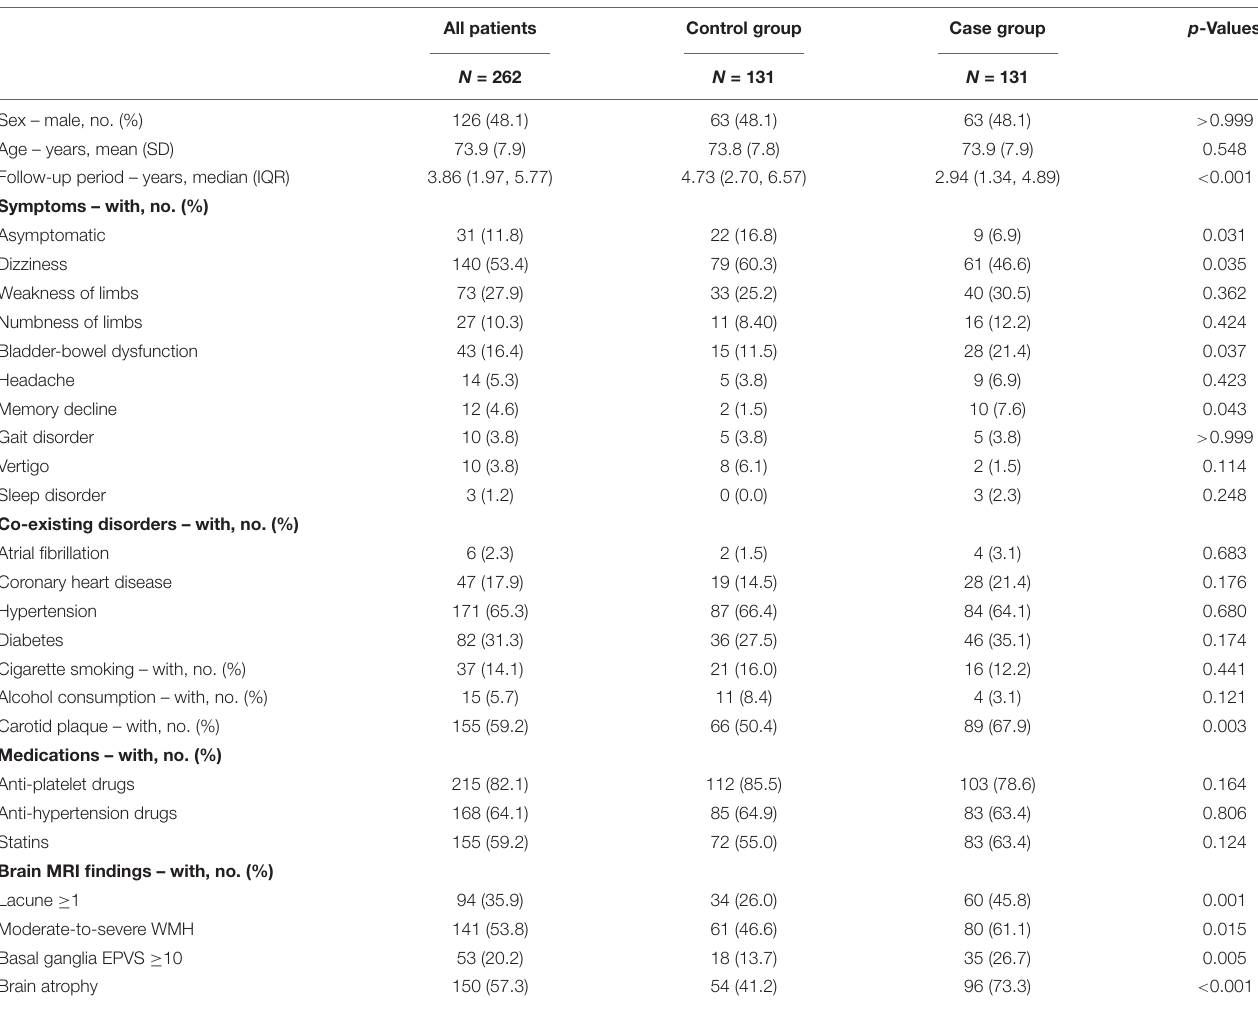
TABLE 1 | The baseline characteristics of study population. All patients Control group Case group p